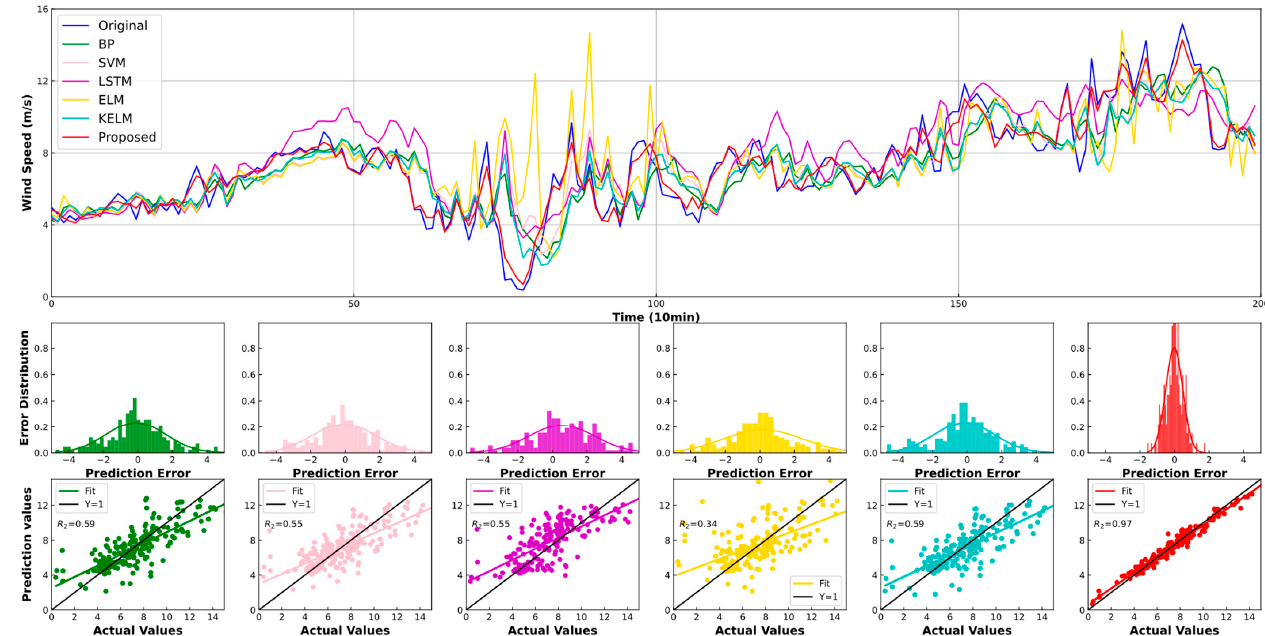
Figure 3. The results of each prediction model in two-step prediction in SH Apr. For SH July, when the forecasting is one-step, the proposed VMD-ISOA-KELM hybrid model achieves the highest accuracy with a MAPE value of 3.140%. Comparatively, the individual models have fairly lower MAPE values of 9.792%, 7.434%, 8.561%, 7.355% and 7.342%, respectively. In the two-step and three-step forecasting, the developed combined model is more effective than the other methods for wind speed forecasting. Meanwhile, KELM has the lowest MAPE values at 7.342% and 9.883% in the one-step and two-step among the remaining four individual models.